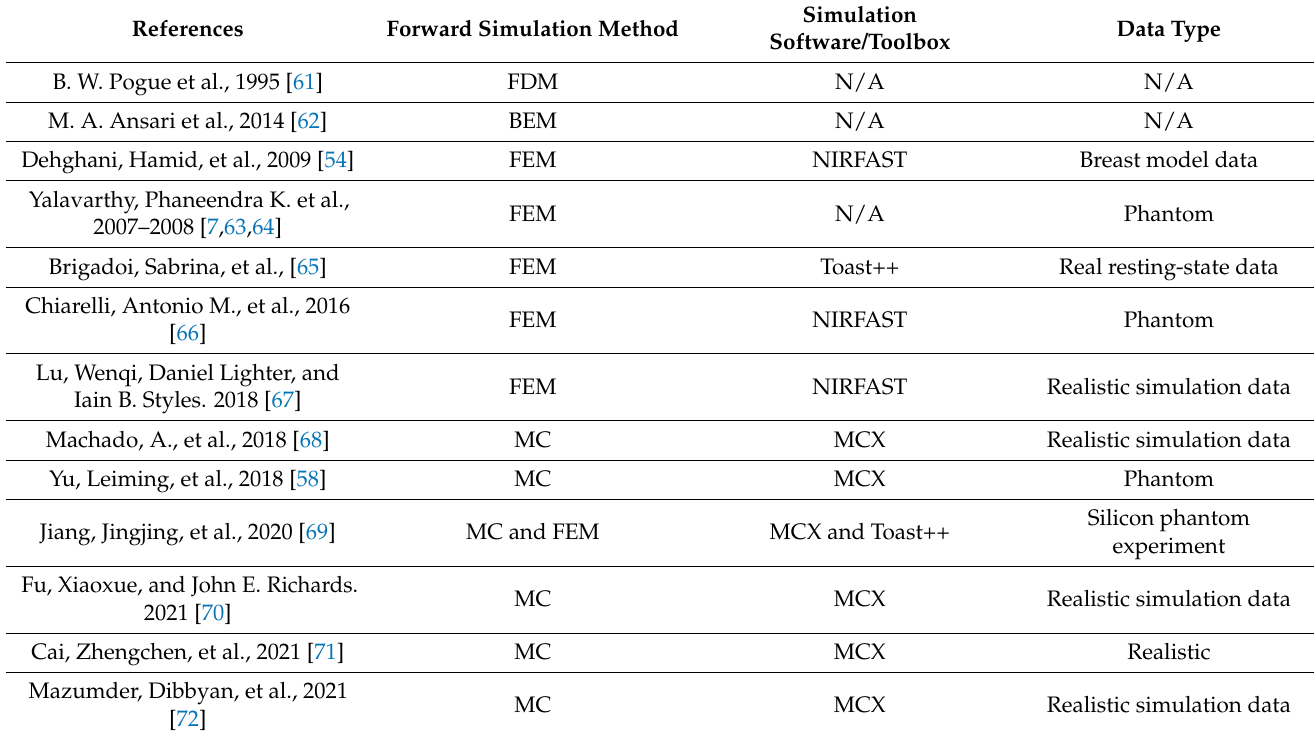
Table 1. Details about the various methods and types of toolboxes/software used for the simulation forward problem in fNIRs